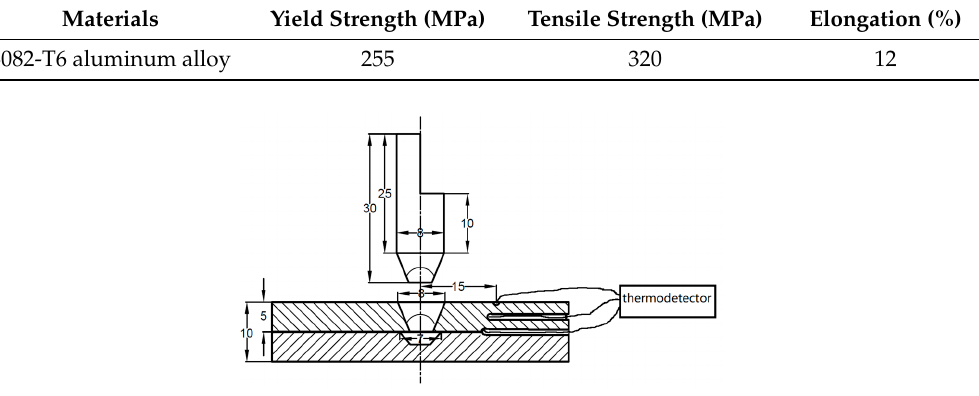
Figure 1. Plug and hole structure diagram and temperature measurement location. Table 2. The chemical composition of 6082 aluminum alloy (in wt. Table 1. The mechanical property of 6082-T6 aluminum alloy.